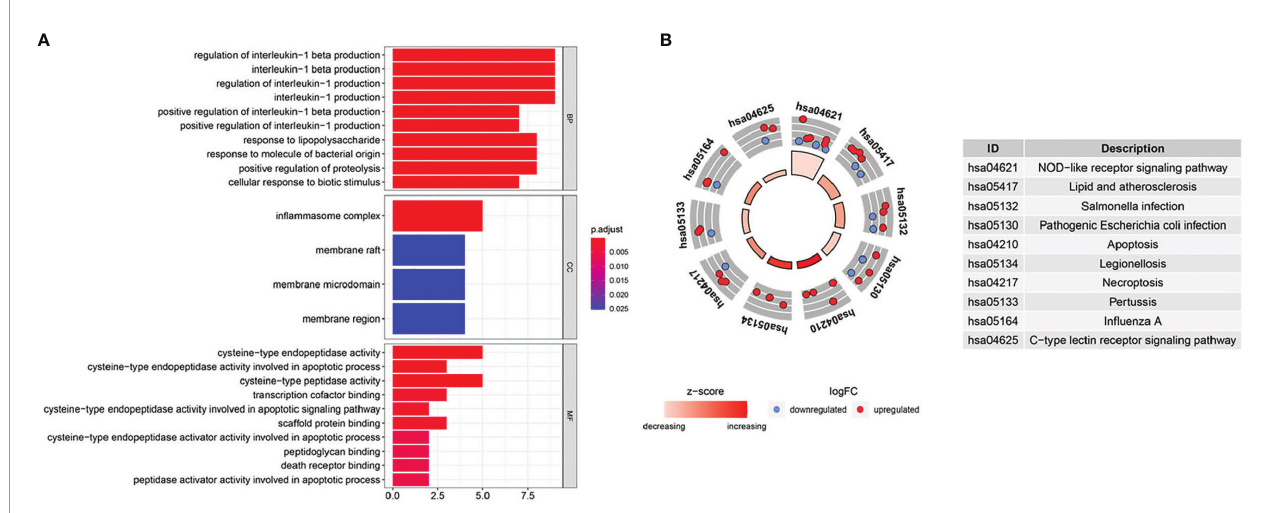
FIGURE 3 | GO and KEGG enrichment analysis. (A) GO analysis of 31 DEPRGs. (B) The top 10 most enriched KEGG pathways analysis of 31 DEPRGs.